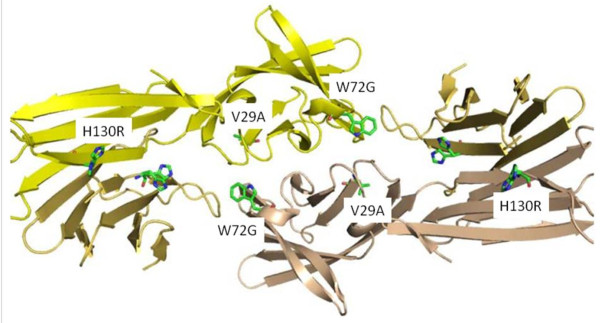
Position of 3 typical amino acid changes in BARF1 positioned into the hexameric structure (kindly provided by dr. N.Tarbouriech).